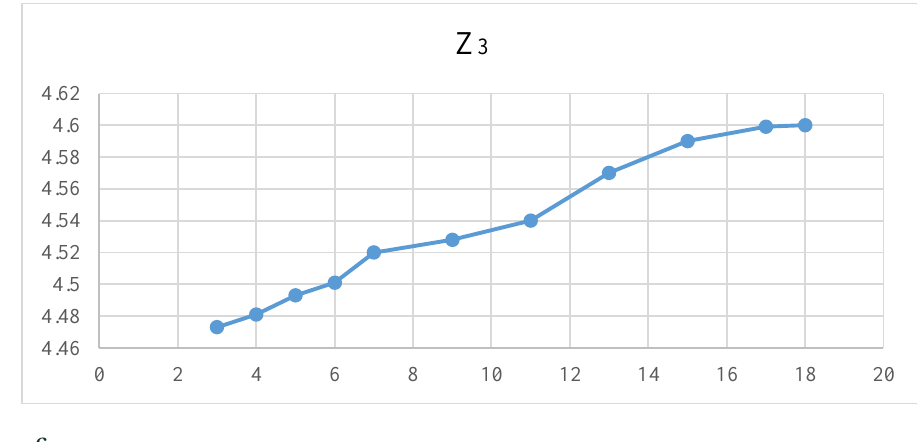
Fig. 4. The effect of n parameter on objective functions.